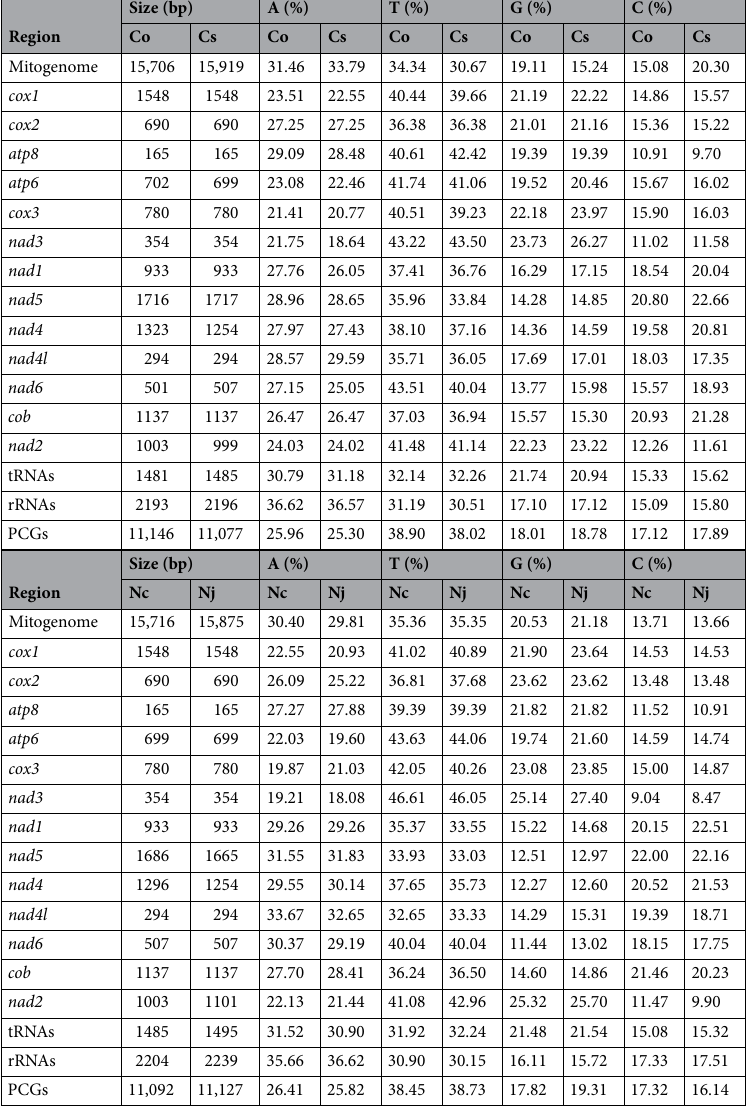
Table 3. Nucleotide composition of the mitogenomes of four Neritidae